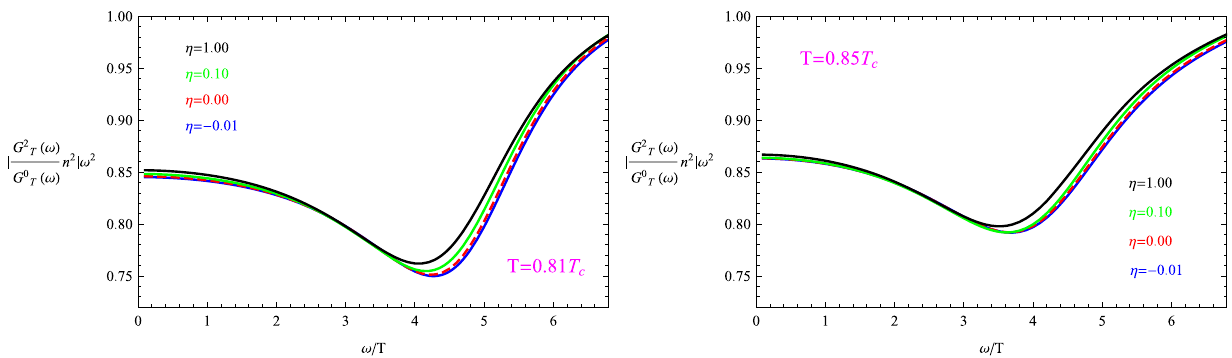
(ω) 2 T Fig. 11 | G n 2 | ω 2 as a function of ω/ T with the fixed temperatures T = 0 . 81 T c (left) and T = 0 . 85 T c (right) for different values of the G 0 T (ω) coupling parameter, i.e., η = − 0 . 01 (blue), 0 . 00 (red dotted), 0.10 (green) and 1 . 00 (black), respectively. We have set the graviton mass m = 1 . 0 in the numerical computation